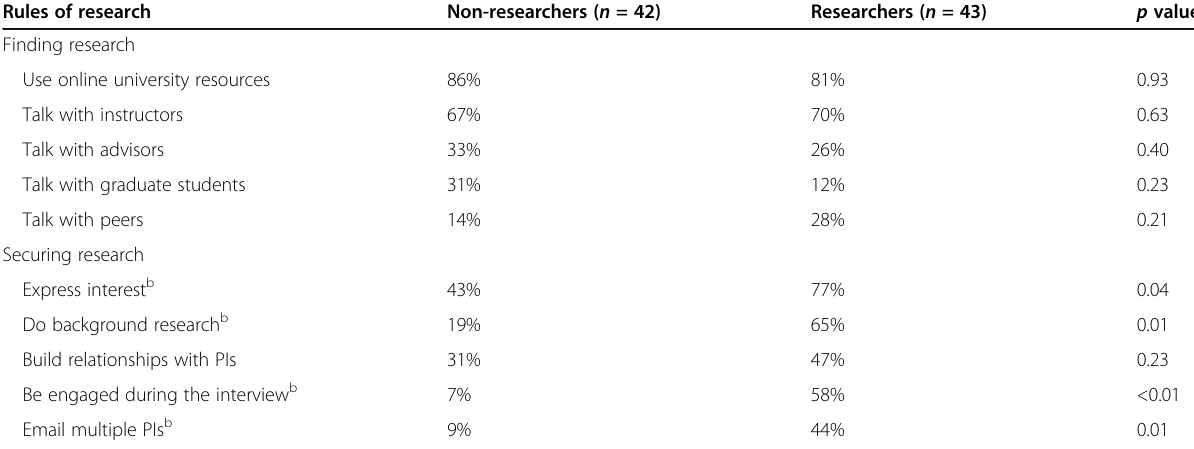
Table 3 Percent of non-researchers and researchers who reported each rule during the